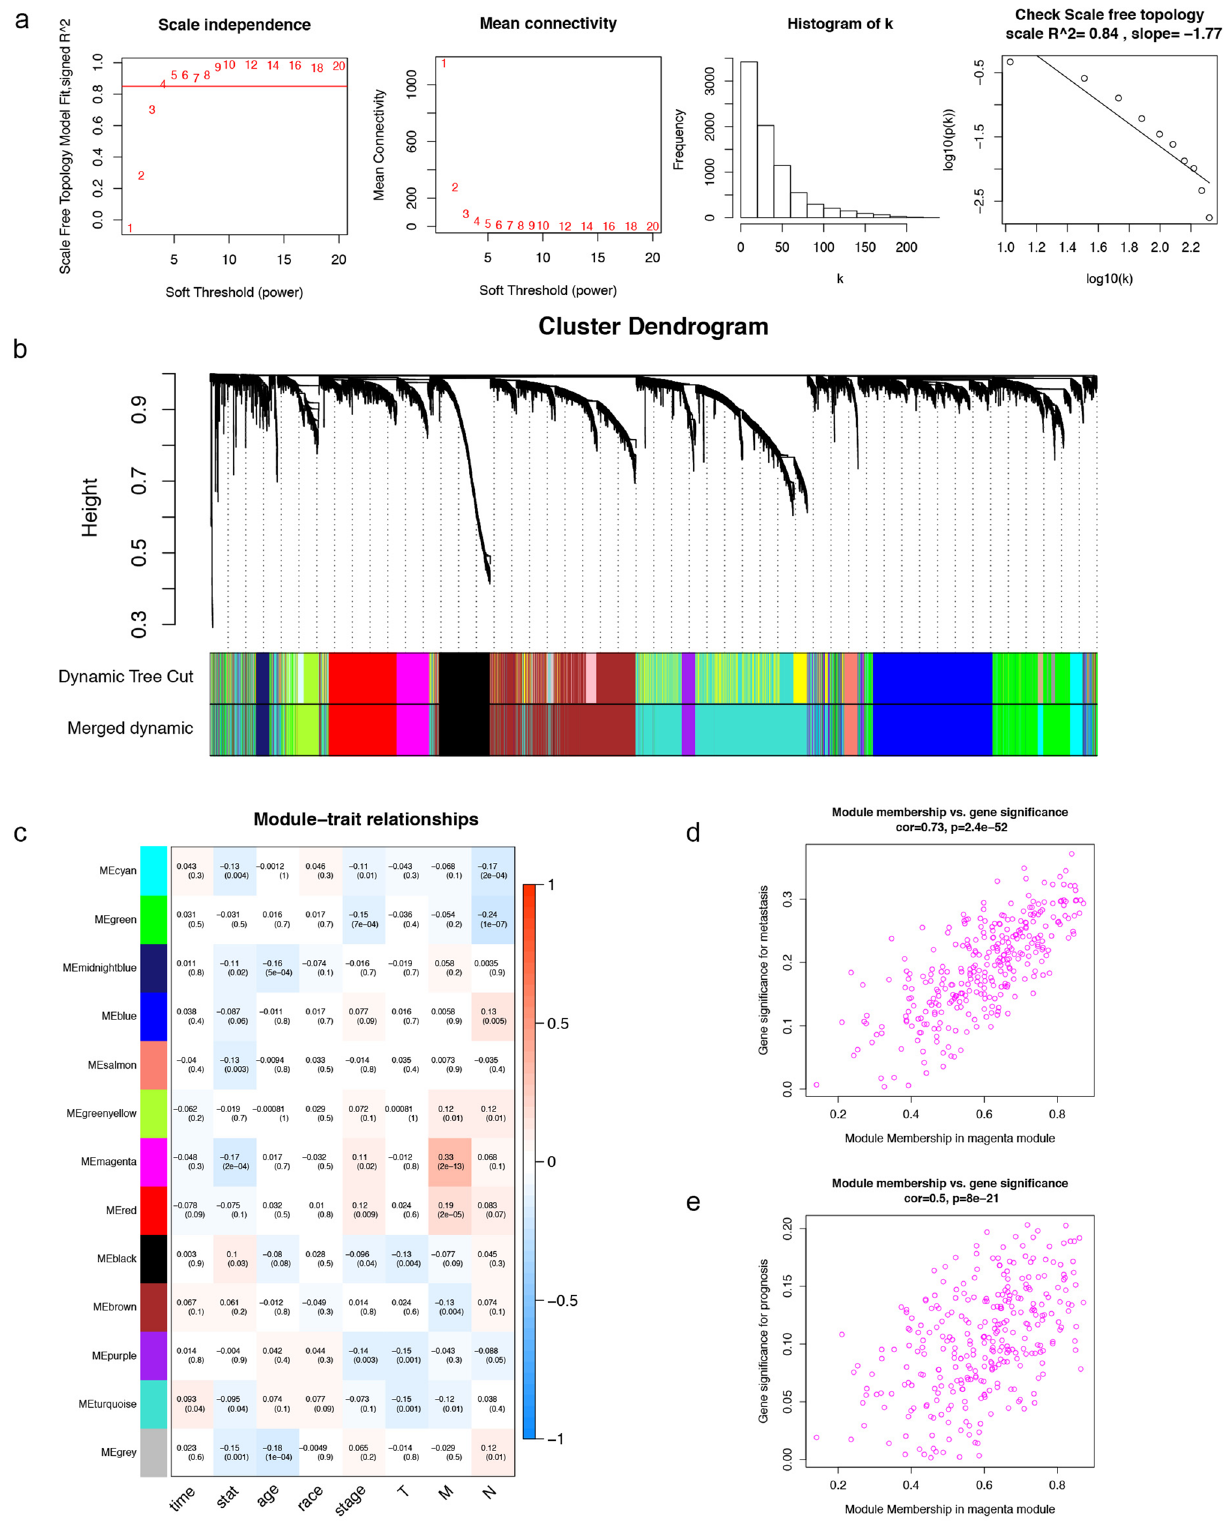
Figure 5. Co-expression network analysis by WGNCA. ( a ) Soft-threshold power analysis for network topology and the test of property of scale-free network. ( b ) Dendrogram of all DEmRNAs clustered based on a dissimilarity measure (1-TOM). ( c ) The relationships between modules and clinical traits. Magenta module was identified to be the most significant association with metastasis and prognosis in HNSCC patients. ( d ) The correlation between the magenta module membership and metastasis. ( e ) The correlation between the magenta module membership and